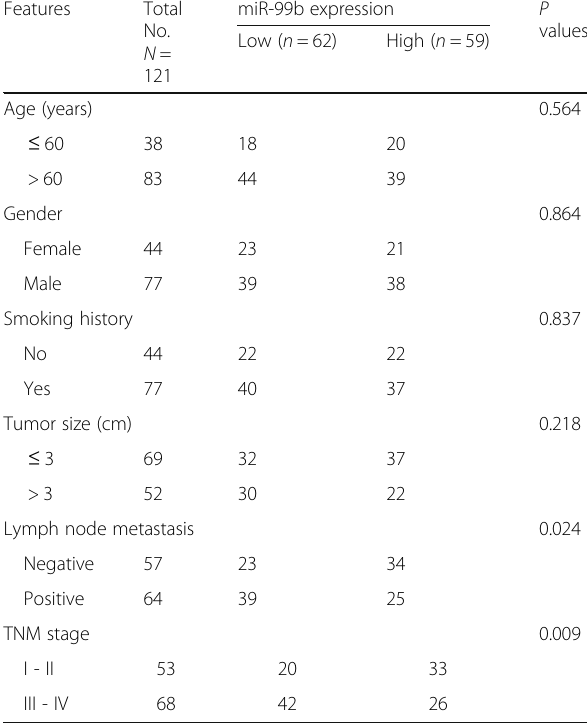
Fig. 2 Kaplan-Meier survival curves for the patients with NSCLC. Low miR-1298 expression was associated with shorter survival time when Table 1 Association of miR-1298 and the clinical characteristics of the NSCLC patients